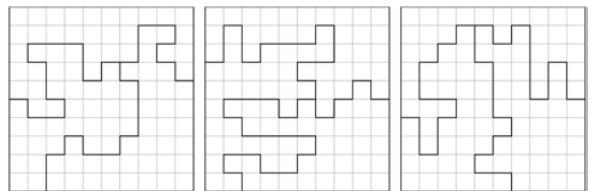
Figure 2. Three alternative aggregations found by the